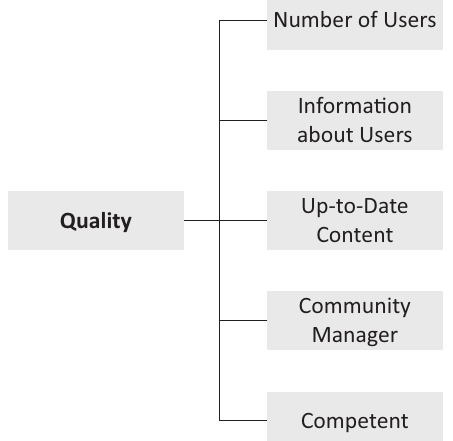
Figure 5. Advertisers’ expectations towards the quality of a community.